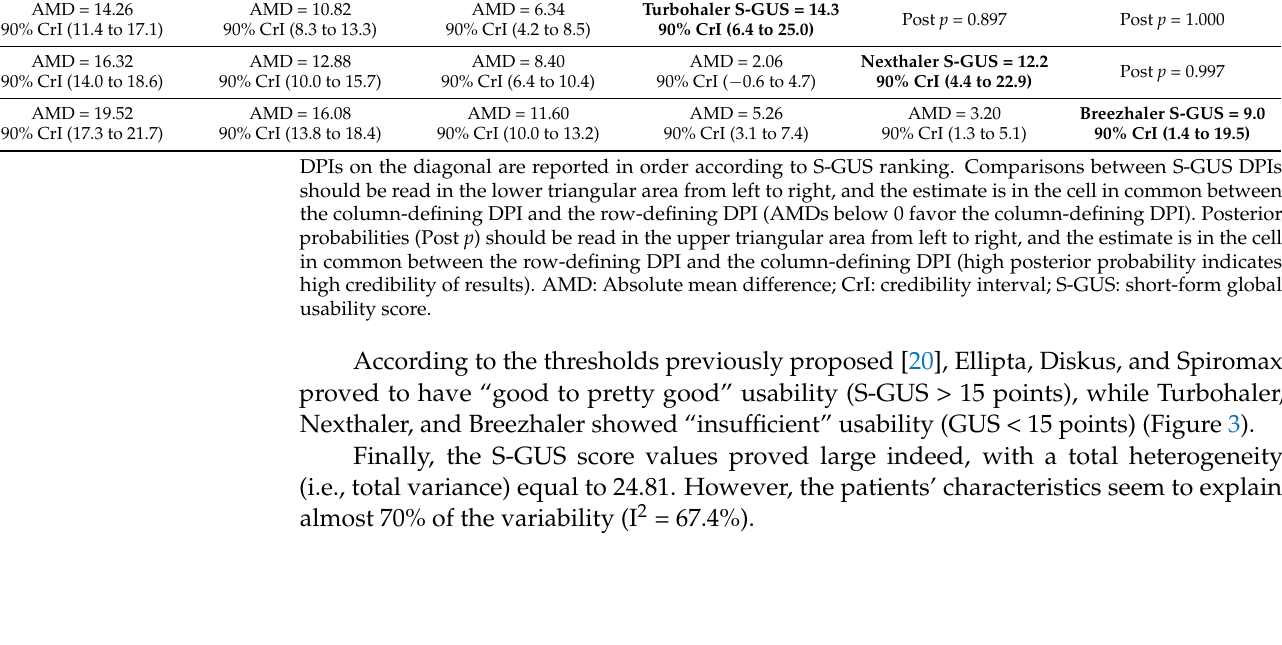
Table 2. Results of the Bayesian analysis on the six DPIs analyzed.